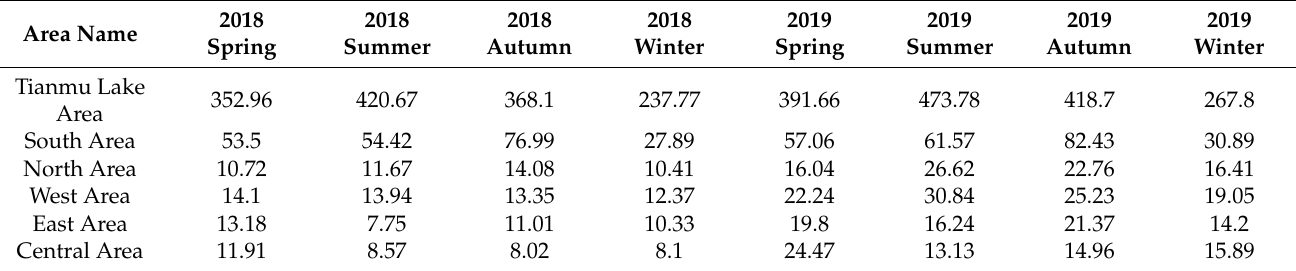
Table 7. List of tourism numbers by season in each area of Liyang,